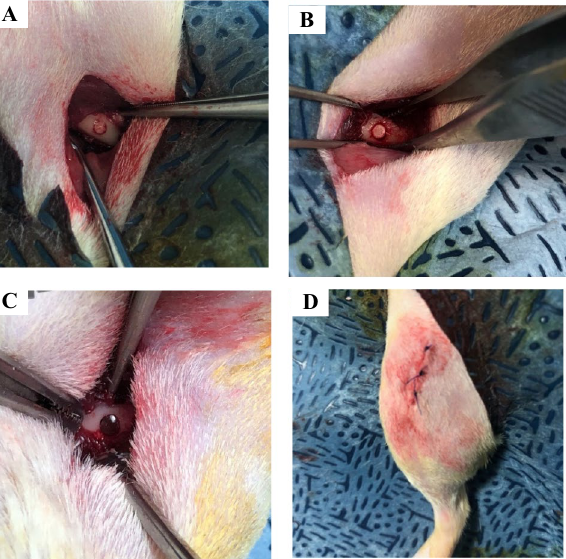
Figure 2. The above images illustrate surgical procedures during the implantation of CSMA and CSMA + 50% CaP in a rat’s femur. The implant was initially inserted into a rat’s femur where the positioning can be observed in a series of images ( A – C ). Image D, however, shows the final suturing before retrieval of the specimens after 4 and 8